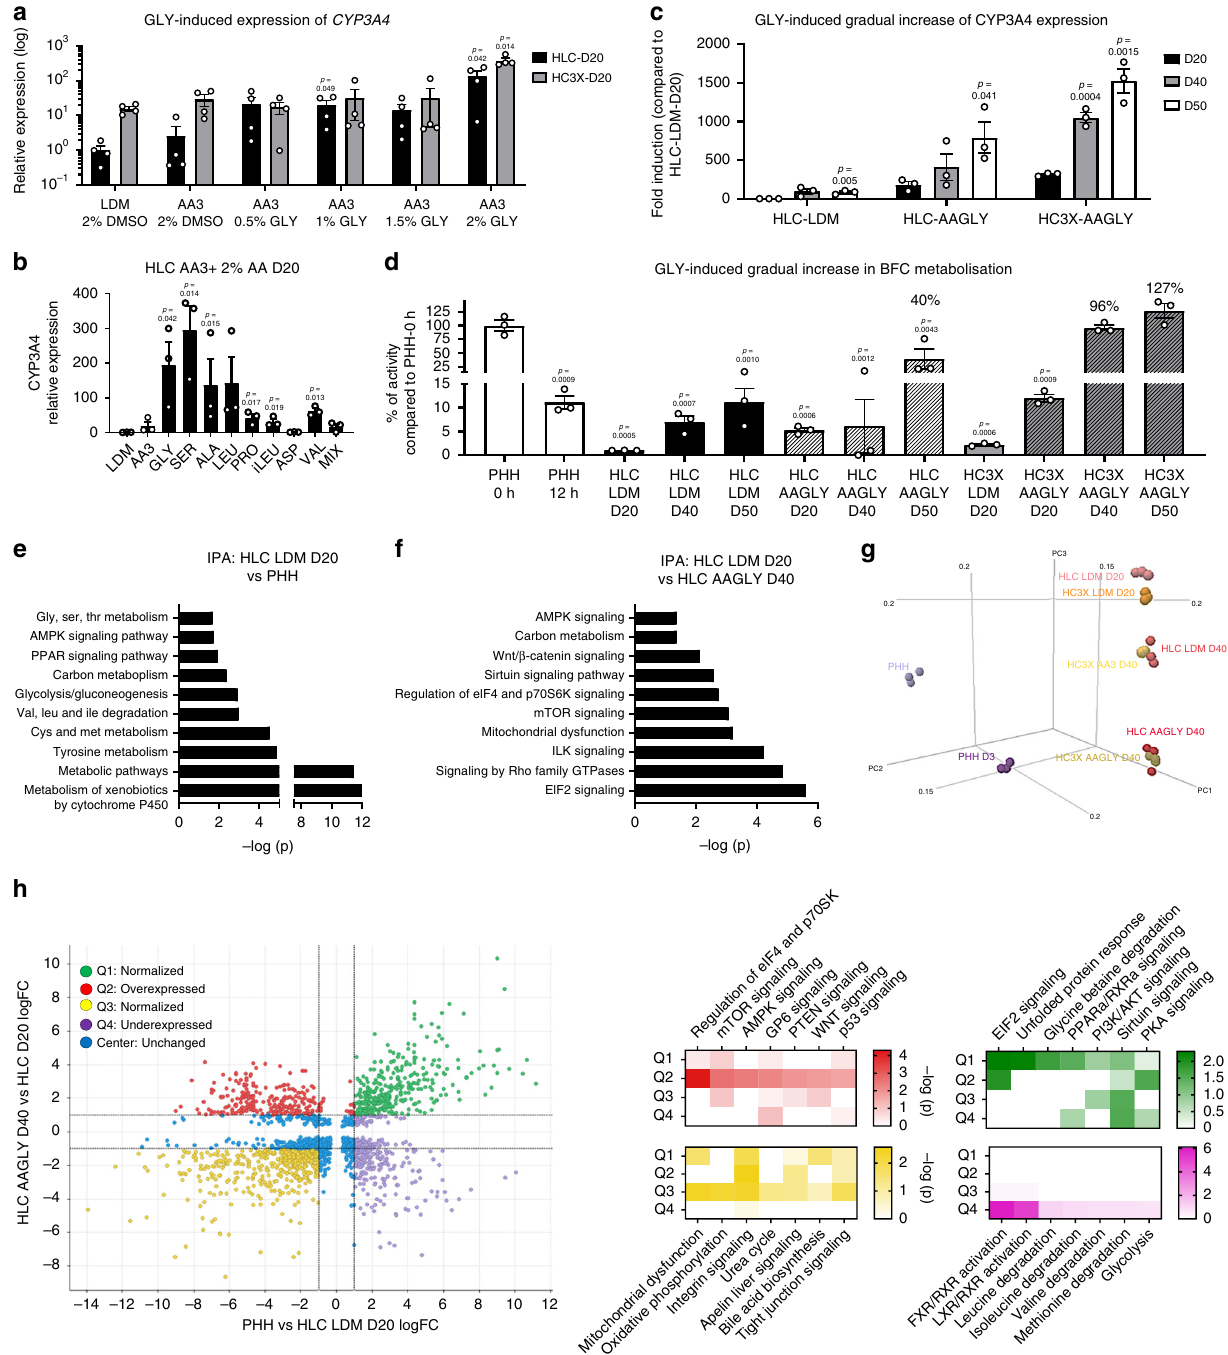
Fig. 4 Elevating AA levels induces time-dependent maturation of HLC and HC3X progeny. a – c Relative CYP3A4 expression in ( a ) HLC D20 and HC3X D20 cultured in control medium and in medium supplemented with AA3, and an increasing amount of glycine; ( b ) in HLCs and HC3X cultured in control and in AAGLY medium at D20, D40, and D50 of differentiation; ( c ) in HLCs cultured in medium supplemented with AA3 with or without 2% of either glycine (GLY), serine (SER), alanine (ALA), leucine (LEU), proline (PRO), isoleucine (iLEU), aspartate (ASP), valine (VAL), or a mix of all of the above. N = 3 independent differentiations. Signi fi cance was calculated compared with HLC or HC3X LDM D20 with 2% DMSO by unpaired two-tailed Student ’ s t -test. d Relative CYP3A4/CYP2E1-dependent BFC metabolization for HLCs and HC3X grown in different media conditions at different times of differentiation and compared with PHHs. N = 3 independent differentiations. N = 4 donors for PHH 0 h and PHH 12 h. Signi fi cance was compared with PHH 0 h by unpaired two-tailed Student ’ s t -test. e , f IPA analysis showing major differentially expressed pathways when comparing HLC LDM D20 with ( e ) PHH 0 h and ( f ) HLC AAGLY D40. g PCA plot showing the distribution of HLCs and HC3X differentiated in different media and compared with PHH 0 h. h Quadrant analysis showing pathways that are normalized (Q1 and Q3), overexpressed (Q2), or underexpressed (Q4) when comparing HLC LDM D20 with PHH 0 h and HLC AAGLY D40. Color intensity correlates with − log( p ). Data in all panels represent mean ± SEM with P -values indicated when signi fi cant. Source data are provided as a Source Data fi